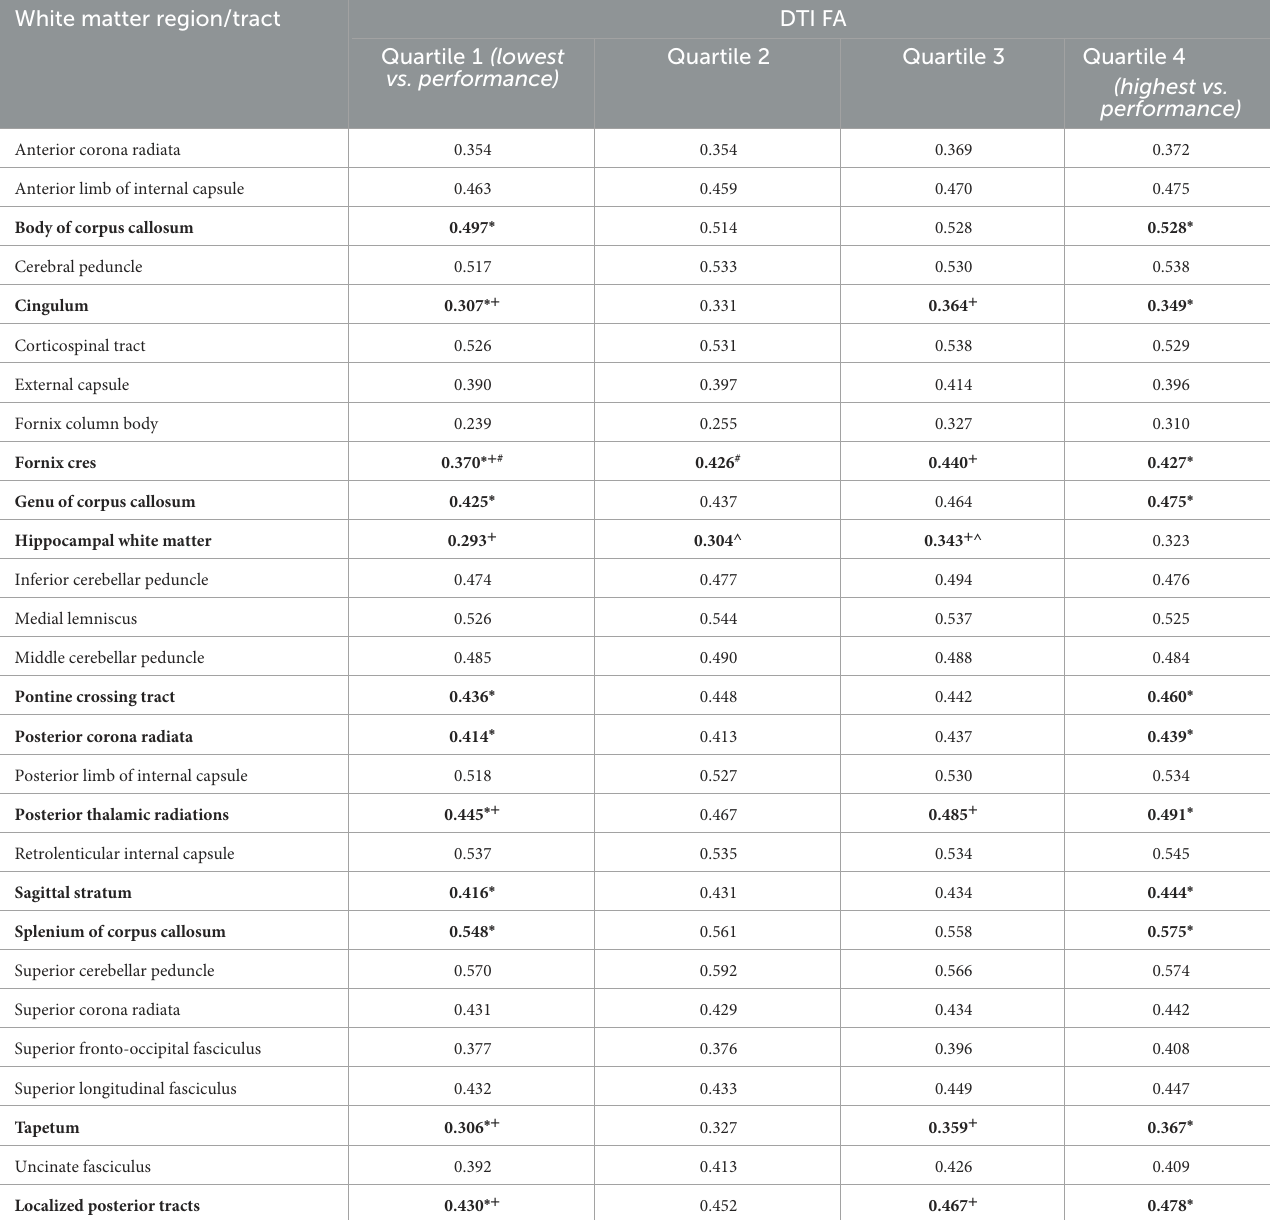
TABLE 3 Mean DTI FA for all white matter region/tracts by visuospatial composite quartile. White matter region/tract DTI FA Quartile 1 (lowest vs.